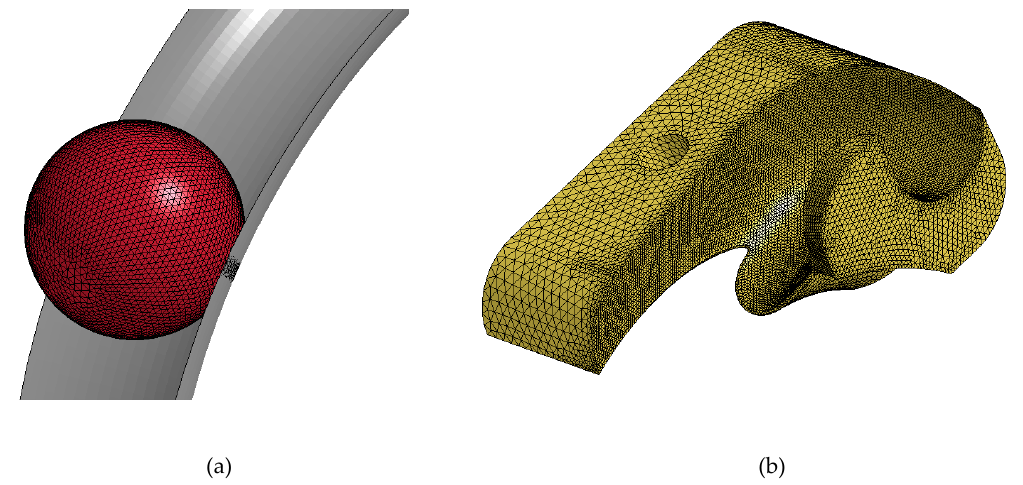
Figure 12. Detailed views of the mesh: ( a ) sphere and ( b ) a recirculating mechanism.